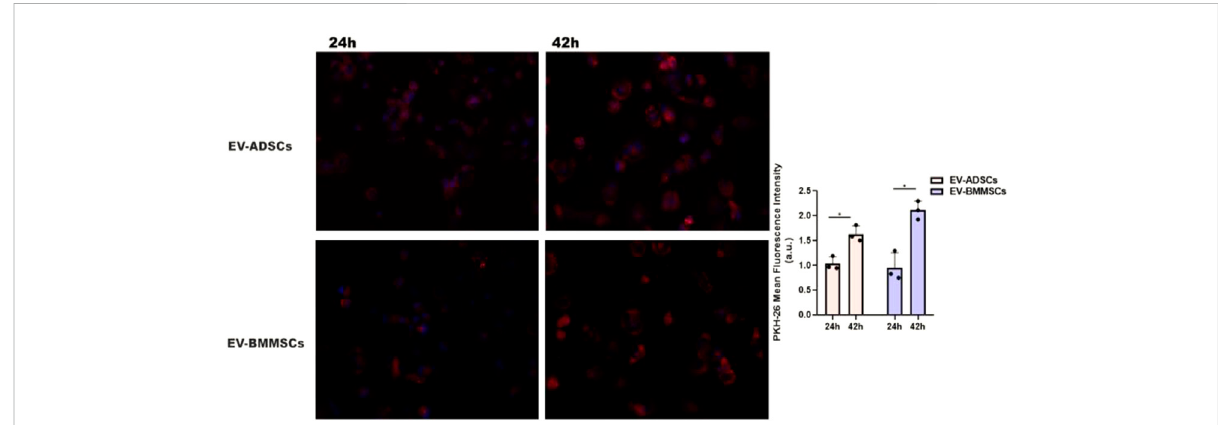
FIGURE 7 In vitro cellular internalization of EV-ADSCs or EV-BMMSCs from clinically healthy subjects by recipient hiPSC-derived cardiomyocytes. For these experiments, the DAPI-stained hiPSC-CMs were incubated with PKH26-labelled EV-ADSCs or EV-BMMSCs for 24 and 42 hours, respectively. Quantitative analysis of fl uorescence intensity of PKH26-labeled EV-ADSCs or EV-BMMSCs revealed differential uptake capacity of the EVs at the two investigated incubation periods with elevated uptake observed at 42 hours, but without signi fi cant internalization differences for the two typesofEVs,respectivelyEV-ADSCsorEV-BMMSCs.Threeindependentexperimentsinduplicatewereconductedby fl uorescencemicroscopy(the original magni fi cation was ×20). Data shown as mean ± SD; One-way ANOVA (* p <